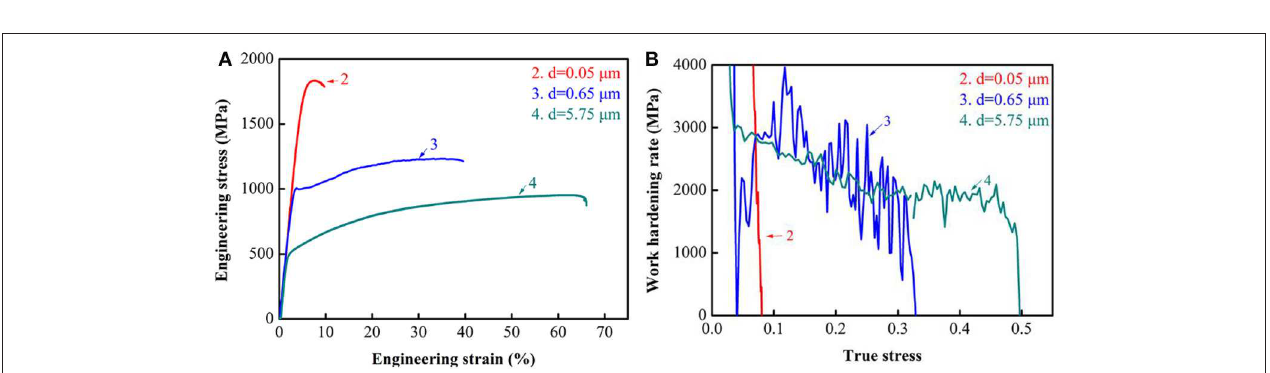
FIGURE 6 | Engineering stress–strain curves and corresponding work hardening curves of the samples with different grain sizes at − 180 ◦ C. (A) Engineering stress–strain curves and (B) corresponding work hardening curves.